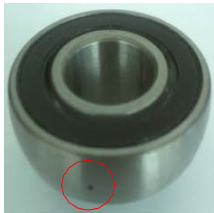
Figure 6. Bearing with a diameter of